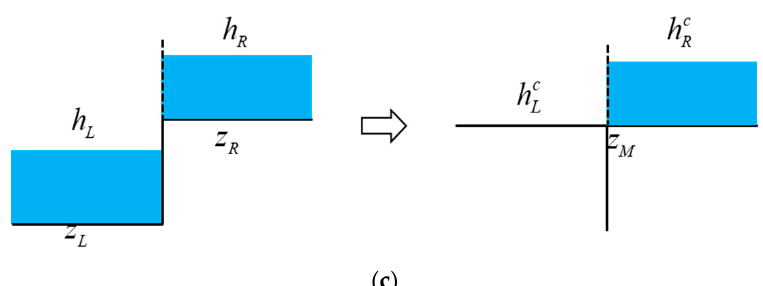
Figure 2. Illustration of hydrostatic reconstruction at: ( a ) h L + z L > h R + z R ; ( b ) h L + z L < h R + z R ; and ( c ) h L + z L < z R.